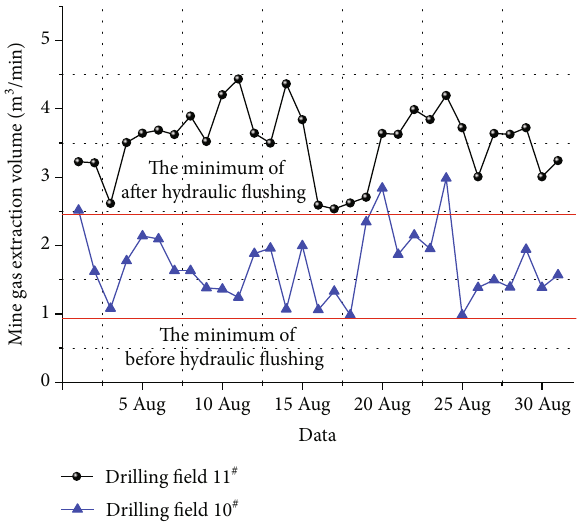
Figure 14: Comparison of CBM extraction amount in di ff erent drilling